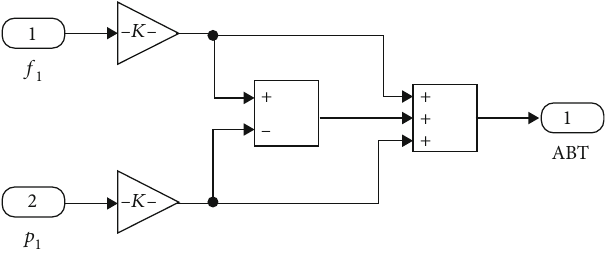
Figure 8: MATLAB Simulink model of the availability-based tari ff pricing scheme.